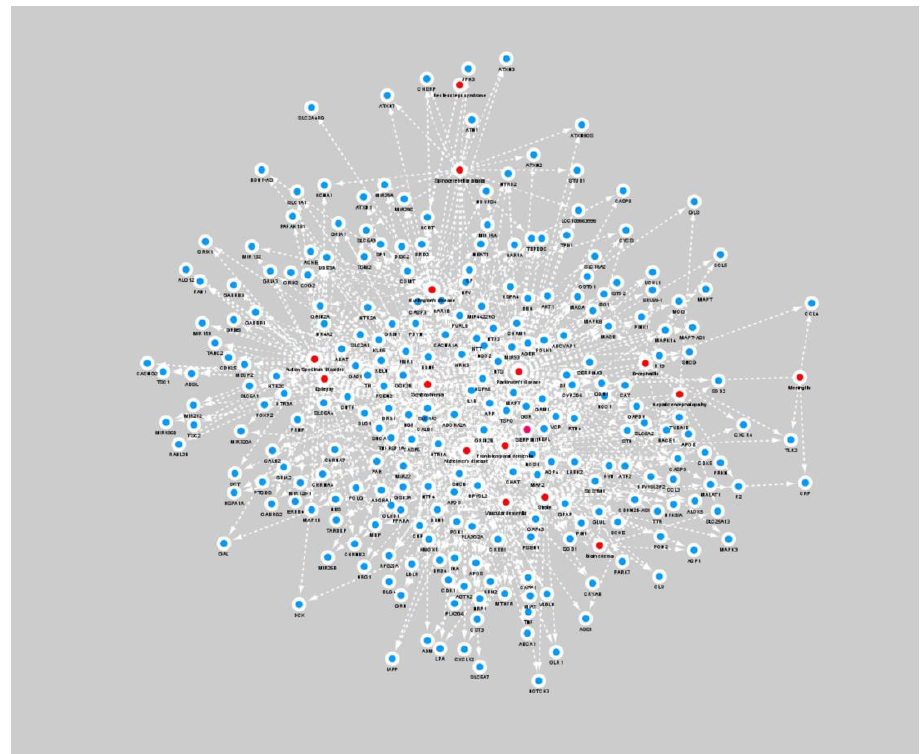
Figure 4. Network of disease–gene associations. Each red node in the figure represents a brain disease, each blue node represents a gene, and each line represents an association between a brain disease and a gene.